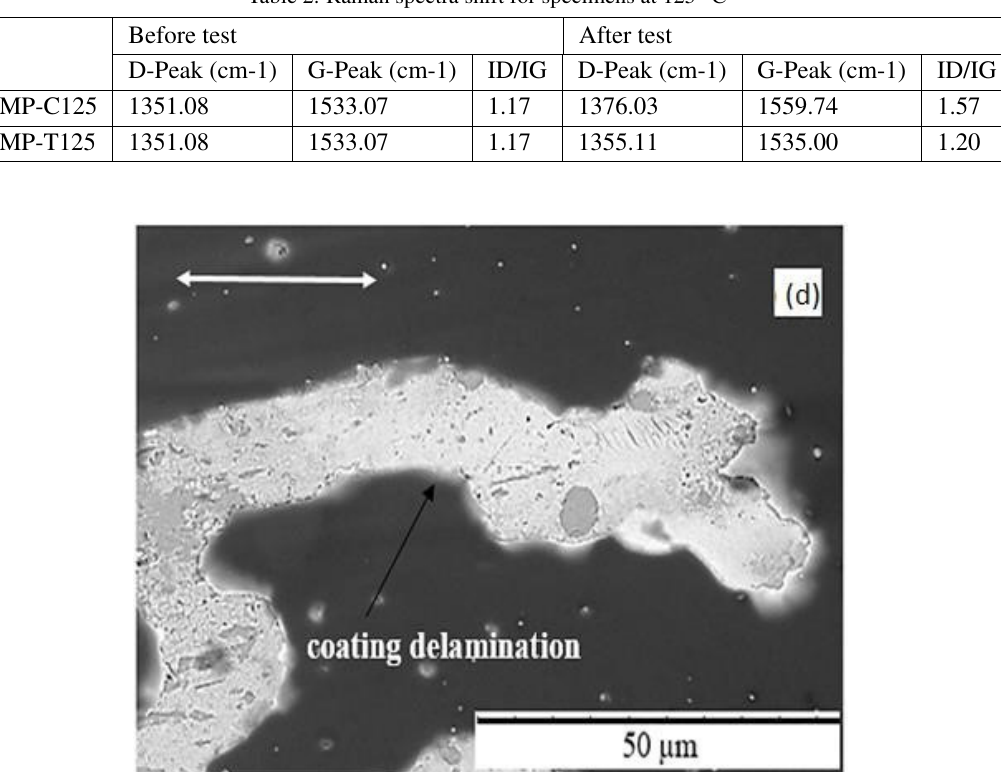
Figure 2. SEM image of un-textured DLC of TMP-C125